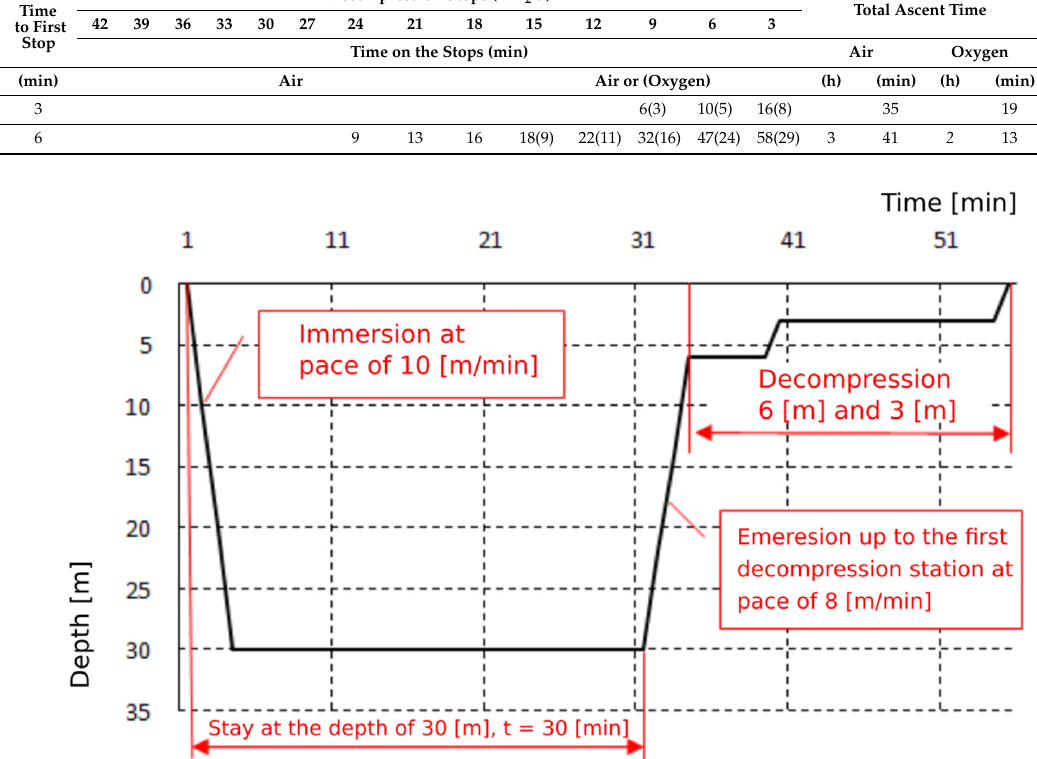
Table 1. 3 MW decompression tables.